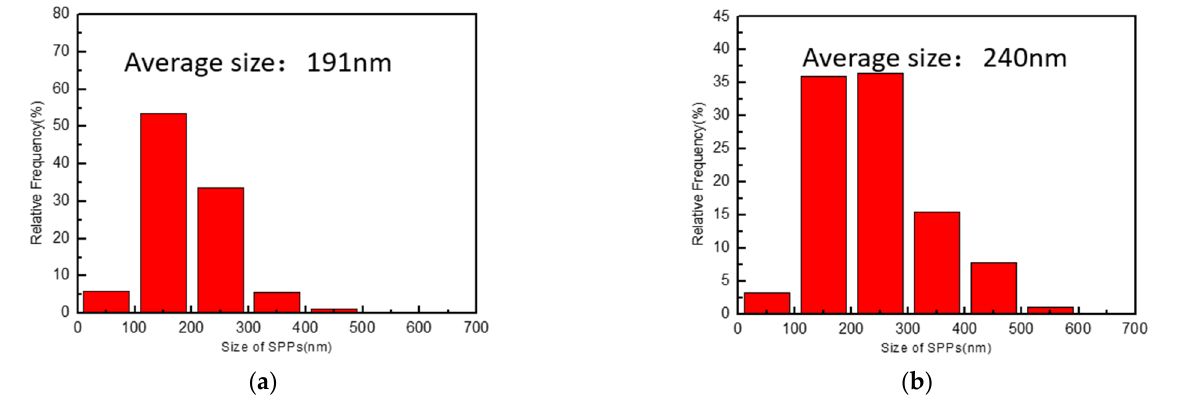
Figure 5. SPP size distribution of ( a ) original plates and ( b ) reprocessed plates. Table 2. Quantitative statistics of SPP size of original plates and reprocessed plates.